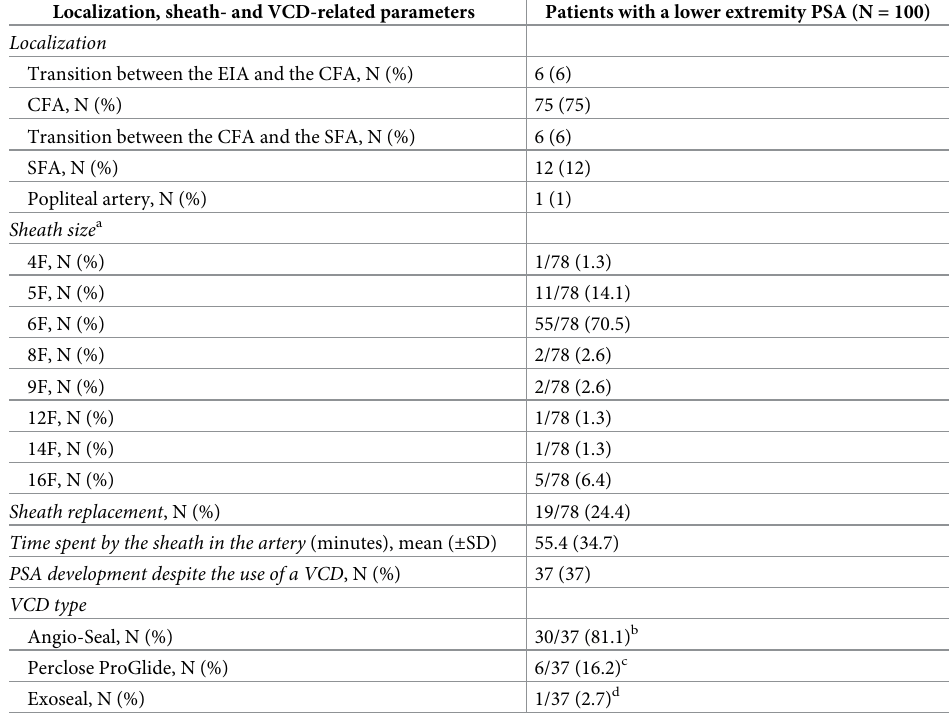
Table 4. Localization, sheath- and vascular closure device-related parameters of patients with a lower extremity pseudoaneurysm. Localization, sheath- and VCD-related